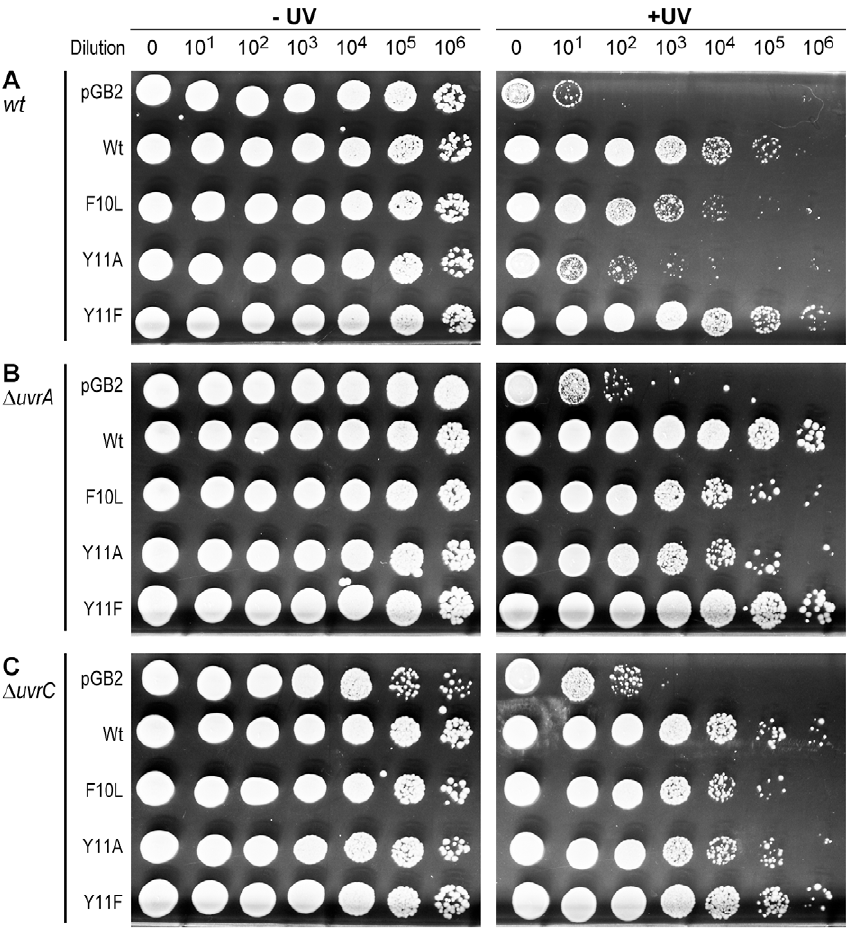
Figure 4. Role of NER in strains expressing pol V variants. 10 m l of 10-fold serial dilutions of overnight cultures were spotted onto the surface of rectangular LB agar plates and exposed to 40 J/m 2 254 nM UV-light (Panel A), or 1 J/m 2 254 nM UV-light (Panels B and C). Both unirradiated ( 2 ) and UV-irradiated ( + ) plates were incubated overnight at 37 u C. In each panel, UV survival is shown for the recA730 lexA (Def) D umuDC D dinB strains either harboring pGB2 vector, or expressing pol V variants. Panel A ( uvr + strain) is reproduced from Figure 1A for direct comparison to the isogenic D uvrA (Panel B) and D uvrC (panel C) strains. The main observation of these experiments is that while the uvr 2 strains are considerably more UV- sensitive than the isogenic uvr + strain, the relative sensitivity of the strains expressing pol V variants changes in the uvr 2 background, with UmuC_Y11A promoting an increase in UV-survival to a similar extent as wild-type pol V.